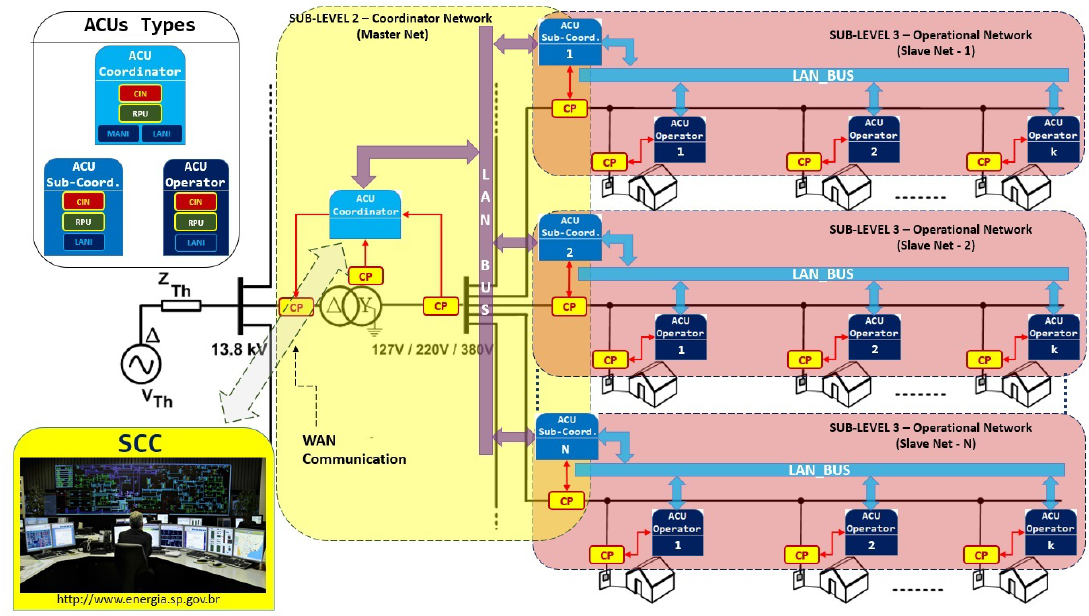
Figure 7. Description of the hierarchical architecture, systemic organization and ACU interactions in the three levels of the smart circuit (SC)